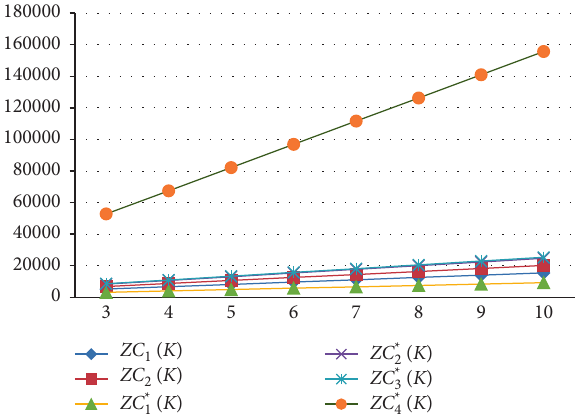
Figure 10: Comparison of ZCIs of network K on dimensions 3 ≤ n ≤ 10.